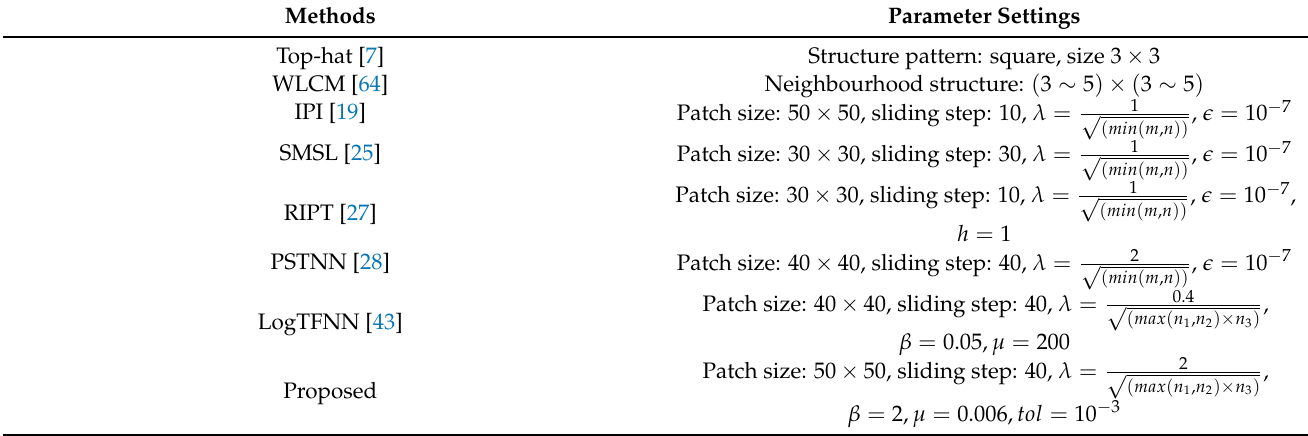
Table 3. Parameters of the eight comparison